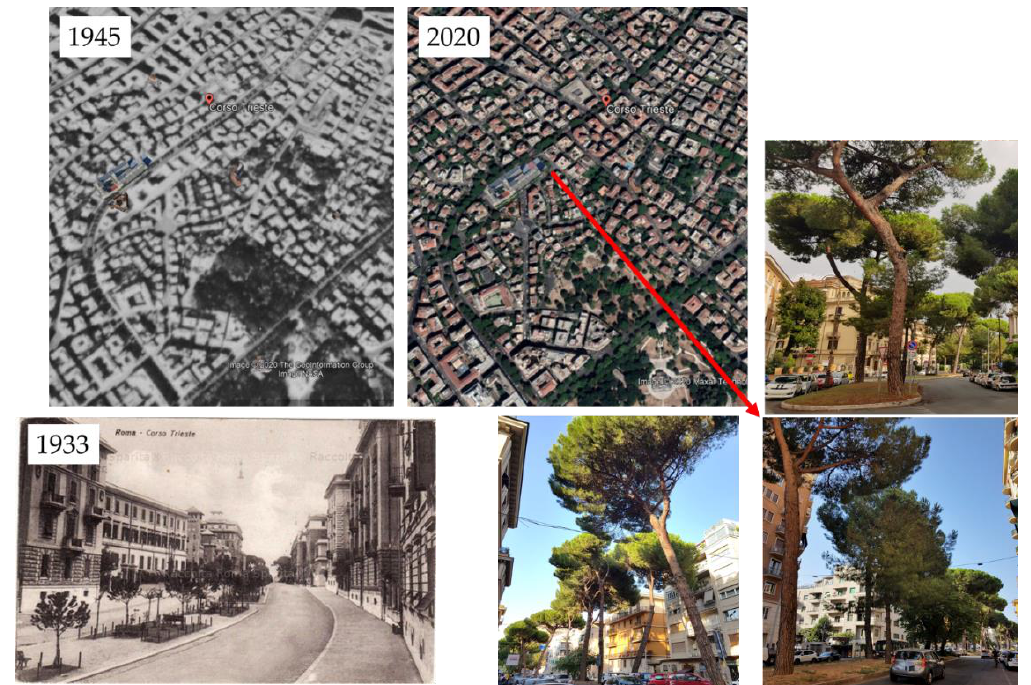
Figure 4. Corso Trieste in Rome (Italy). Left: 1945 satellite image from Google Earth and a 1933 historical photo (https://www.romasparita.eu/foto-roma-sparita/70111/corso-trieste-2, accessed on 31 March 2021). Right: Current satellite images and pictures.